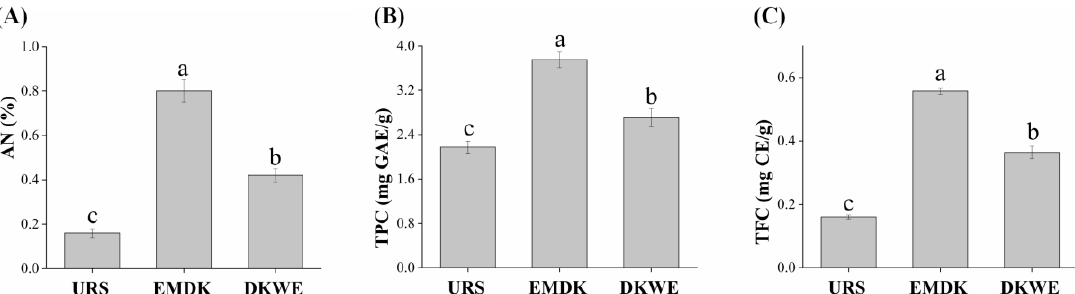
Figure 4. The amino nitrogen (AN), total phenolic content (TPC), and total flavonoid content (TFC) of different samples. ( A ) The amino nitrogen (AN) content; ( B ) The total phenolic content (TPC); ( C ) The total flavonoid content (TFC). Abbreviations: URS, unfermented raw samples; EMDK, edible mushroom by-product Douchi koji; DKWE, Douchi koji without edible mushroom by-product. Values are expressed as the mean ± SD (n = 3). Bars with different lowercase letters represent significant differences ( p < 0.05).